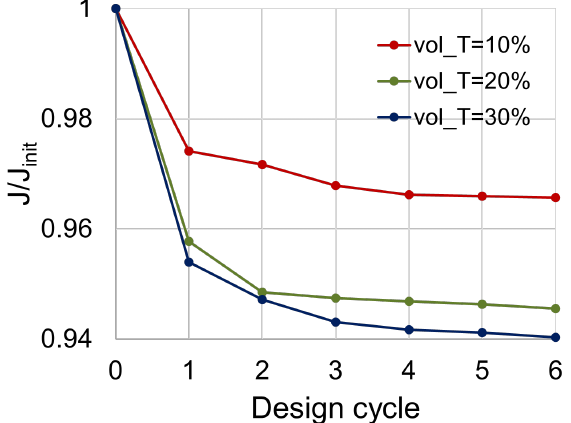
Figure 8. Reduction of the objective function (relative to the non-optimized case) at different design optimization